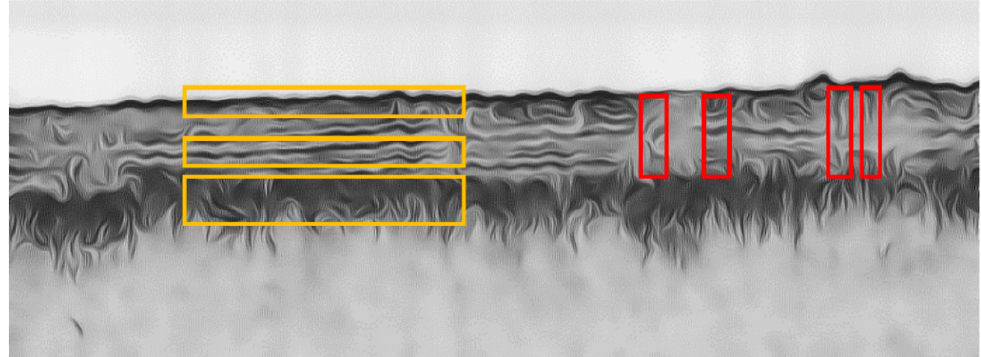
Figure 3. SBP image characteristics after diffusion filtering. Yellow rectangles mark the line-like structures of reflectors. Red rectangles highlight the false vertical structures caused by intensity imbalance phenomena.